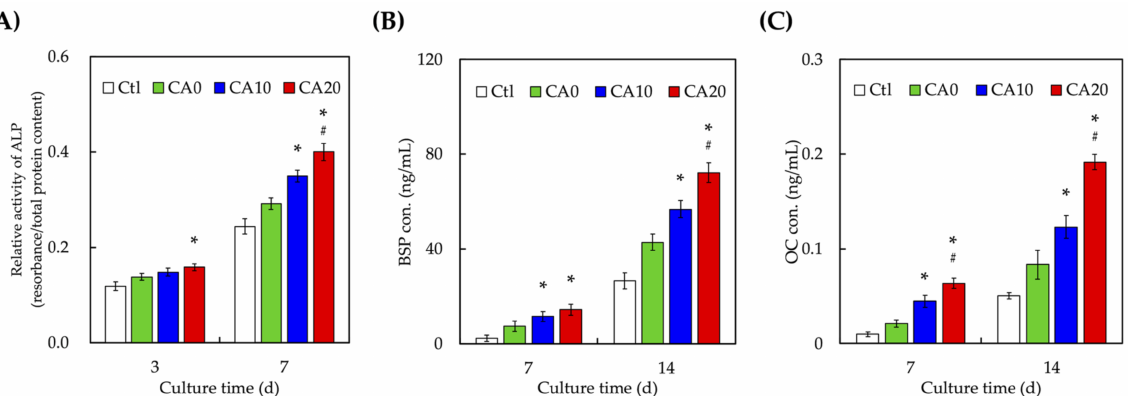
Figure 8. Osteogenesis-related differentiation markers of ( A ) ALP activity ( B ) BSP, and ( C ) OC expression of hDPSCs cultured on CA0, CA10, and CA20 scaffolds for different time points. * indicates a significant difference ( p < 0.05) from CA0. # indicates a significant difference ( p < 0.05) from CA10. Data presented as mean ± SEM; n = 6 for each group.